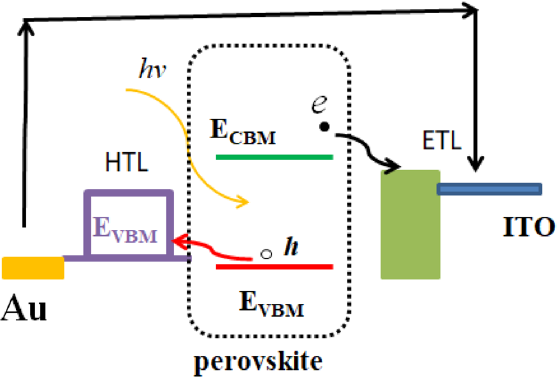
Figure 6. The device configuration and working principle of perovskite solar